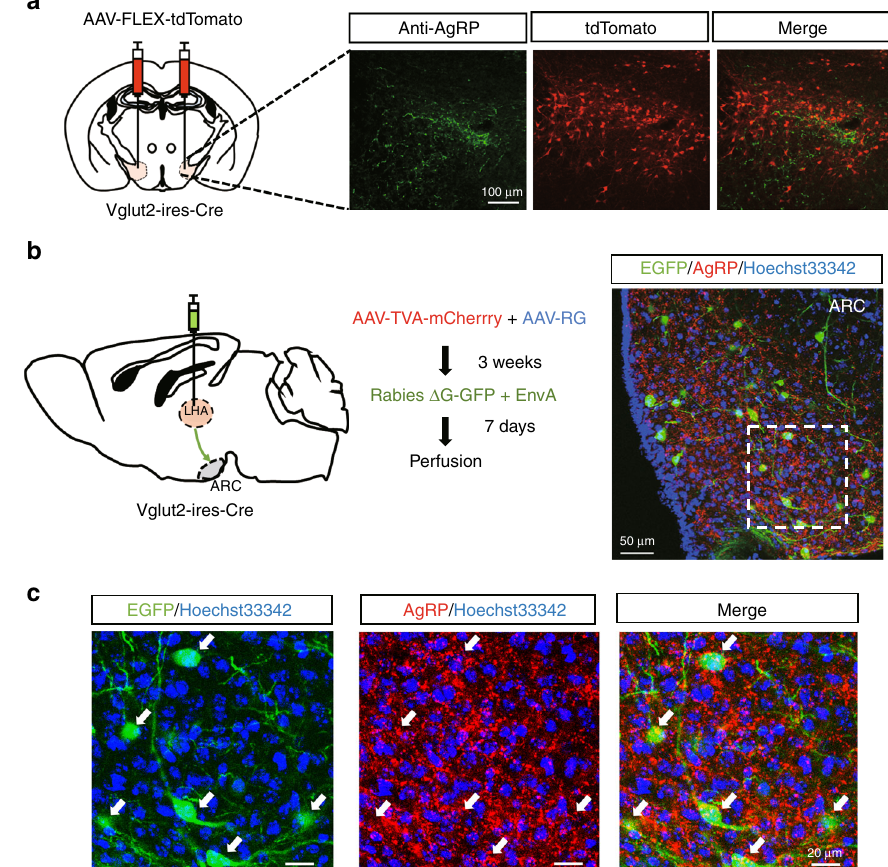
Fig. 4 AgRP neurons connect to parts of the glutamatergic Vglut2-expressing neurons in the LHA. a Representative immunohistochemical image of a coronal section of AgRP axon terminals (green) and Vglut2 neurons (red) in the LHA. Vglut2 neurons were labeled with mCherry by injection of AAV- FLEX-tdTomato in the LHA of Vglut2-ires-Cre mice. b Schematic image of the monosynaptic rabies tracing of Vglut2 neurons in the LHA (left) and a brain section after monosynaptic-tracing neurons in the ARC that are synaptically connected to Vglut2 LHA neurons in the ARC (right). c Enlarged view of ARC neurons that are monosynaptically connected to Vglut2 LHA neurons (green) and AgRP immunostaining (red) in the ARC. Arrows show parts of AgRP neurons monosynaptically connected to Vglut2 LHA